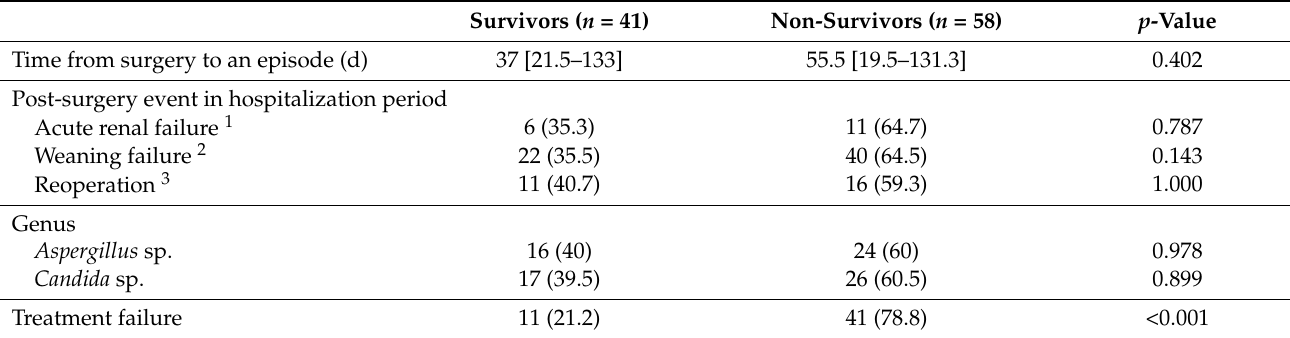
Figure 4. Association between fungal infection and mortality for the IFD and non-IFD groups. Table 4. Comparison of risk factors between overall survivors and non-survivors in the invasive fungal disease